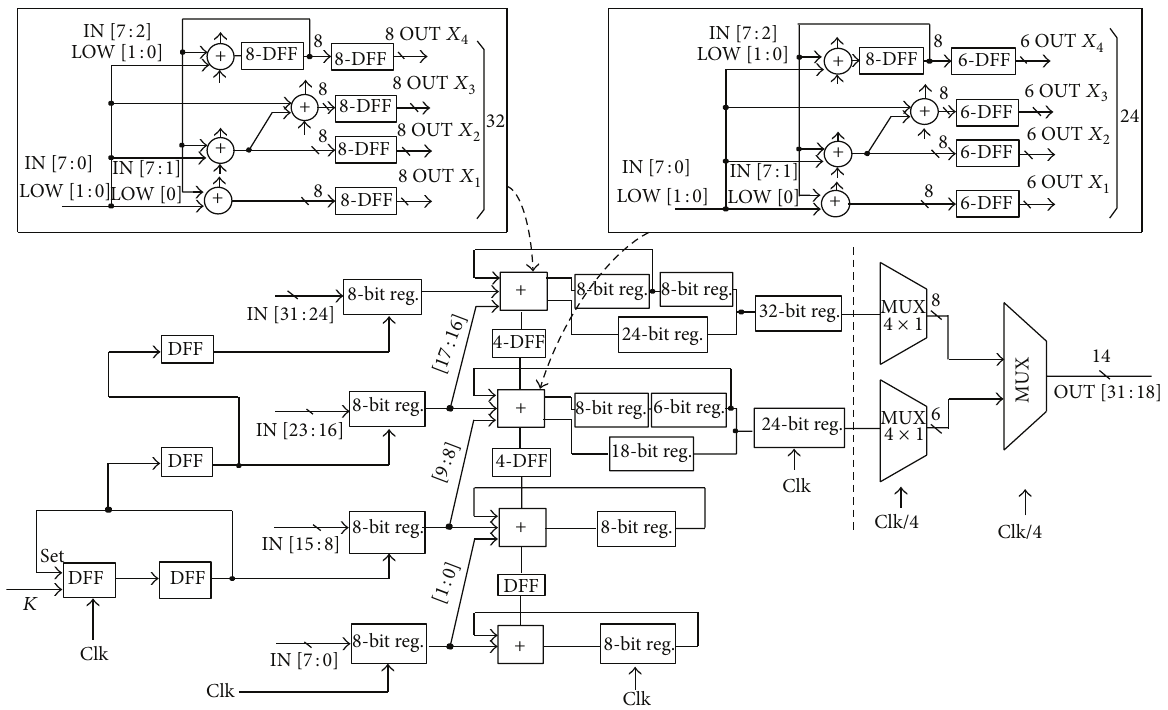
Figure 3: Pipelined phase accumulator with parallel adder based on modifying Bren-Kung adder and gated clocking technique.